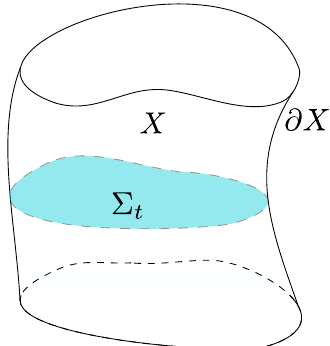
Figure 1 . Schematic representation of the region X , whose spatial boundary ∂X has cylindri- cal